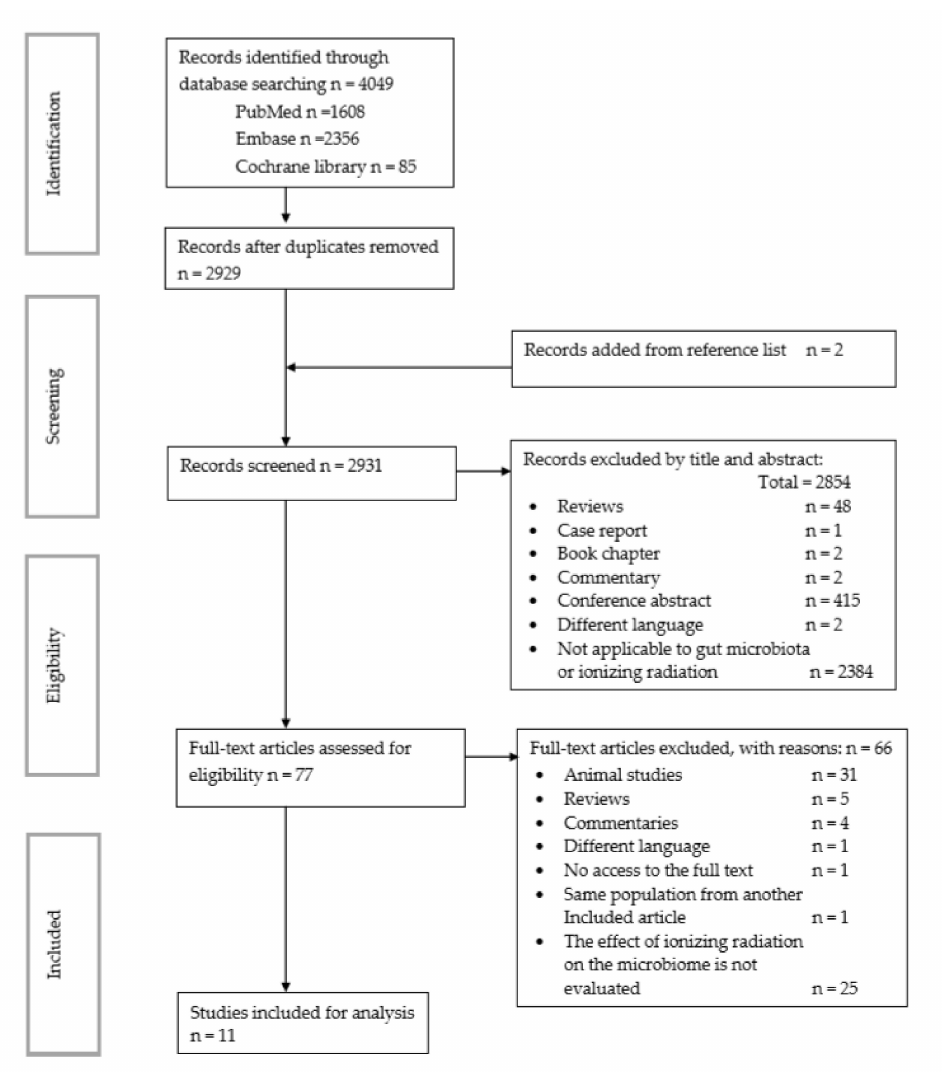
Figure 1. PRISMA flow chart search strategy. Table 1. Literature search algorithm—PubMed.